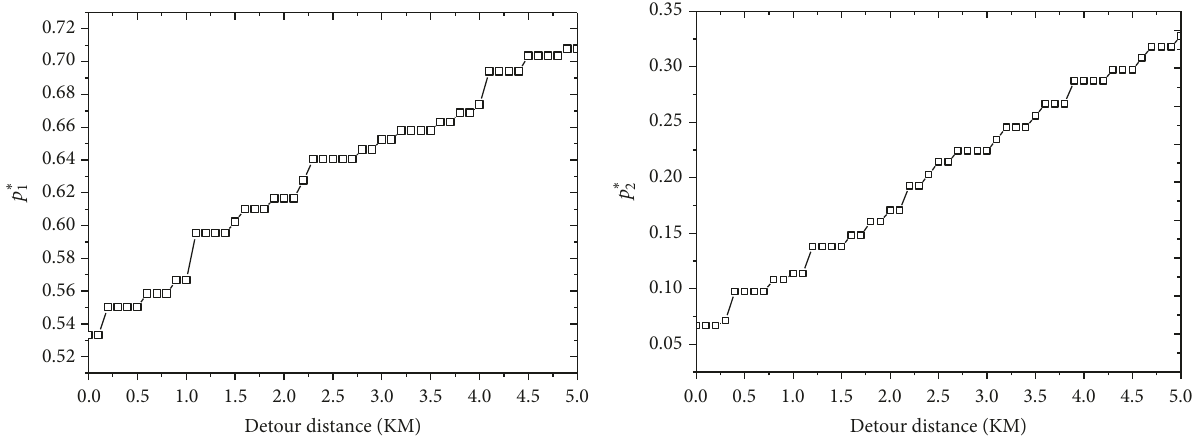
Figure 3: Influence of detour distance on threshold.